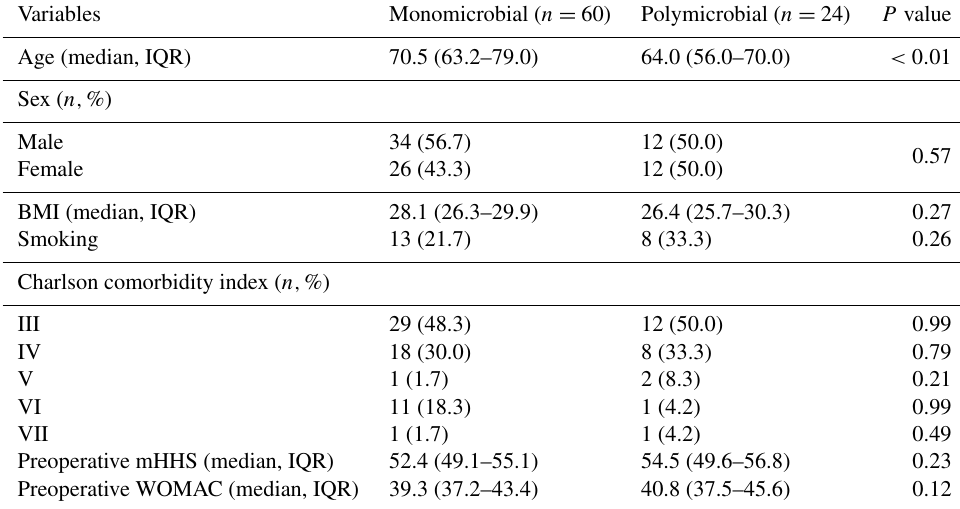
Table 1. Preoperative characteristics of patients included in the study. Variables